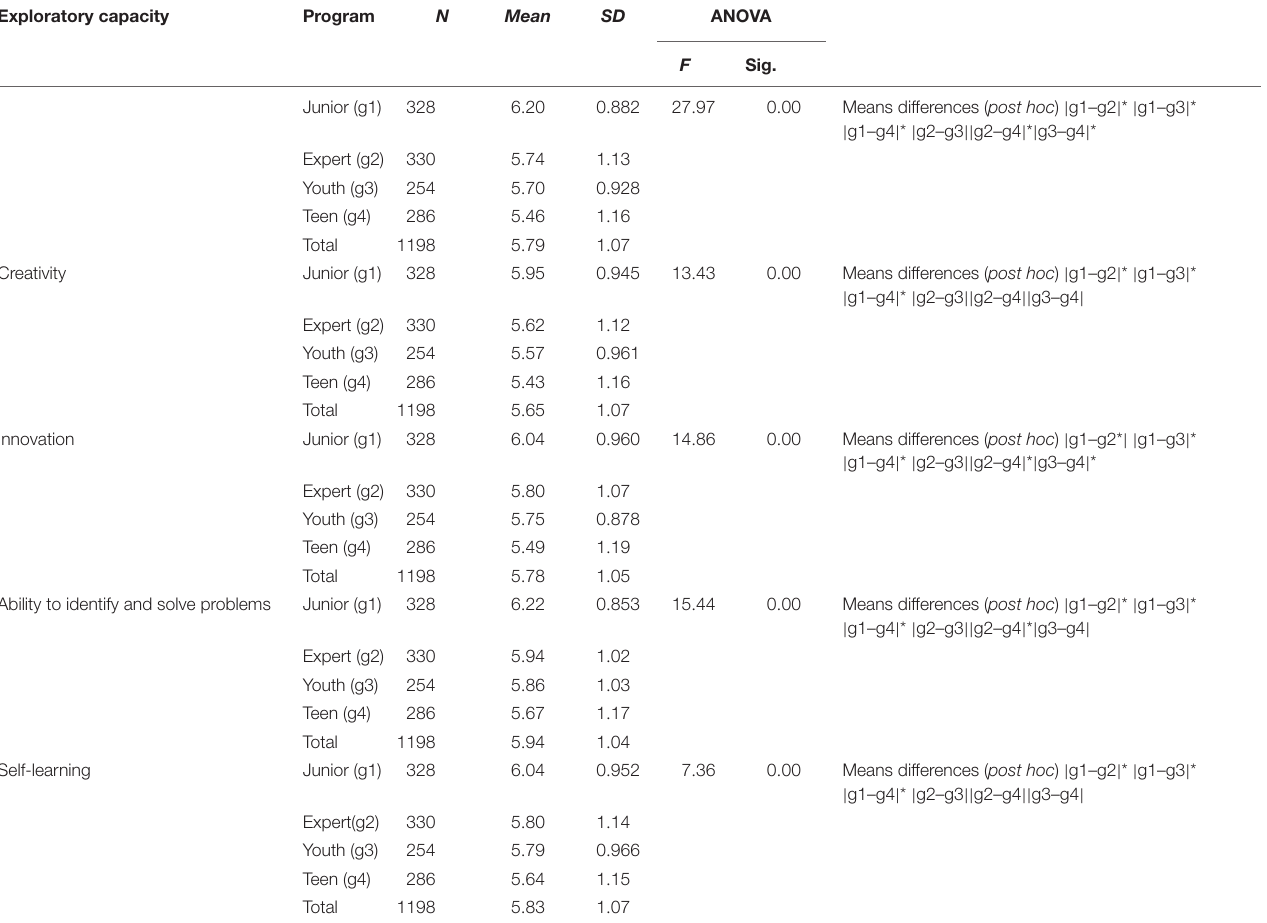
*Significant means difference at 0.05